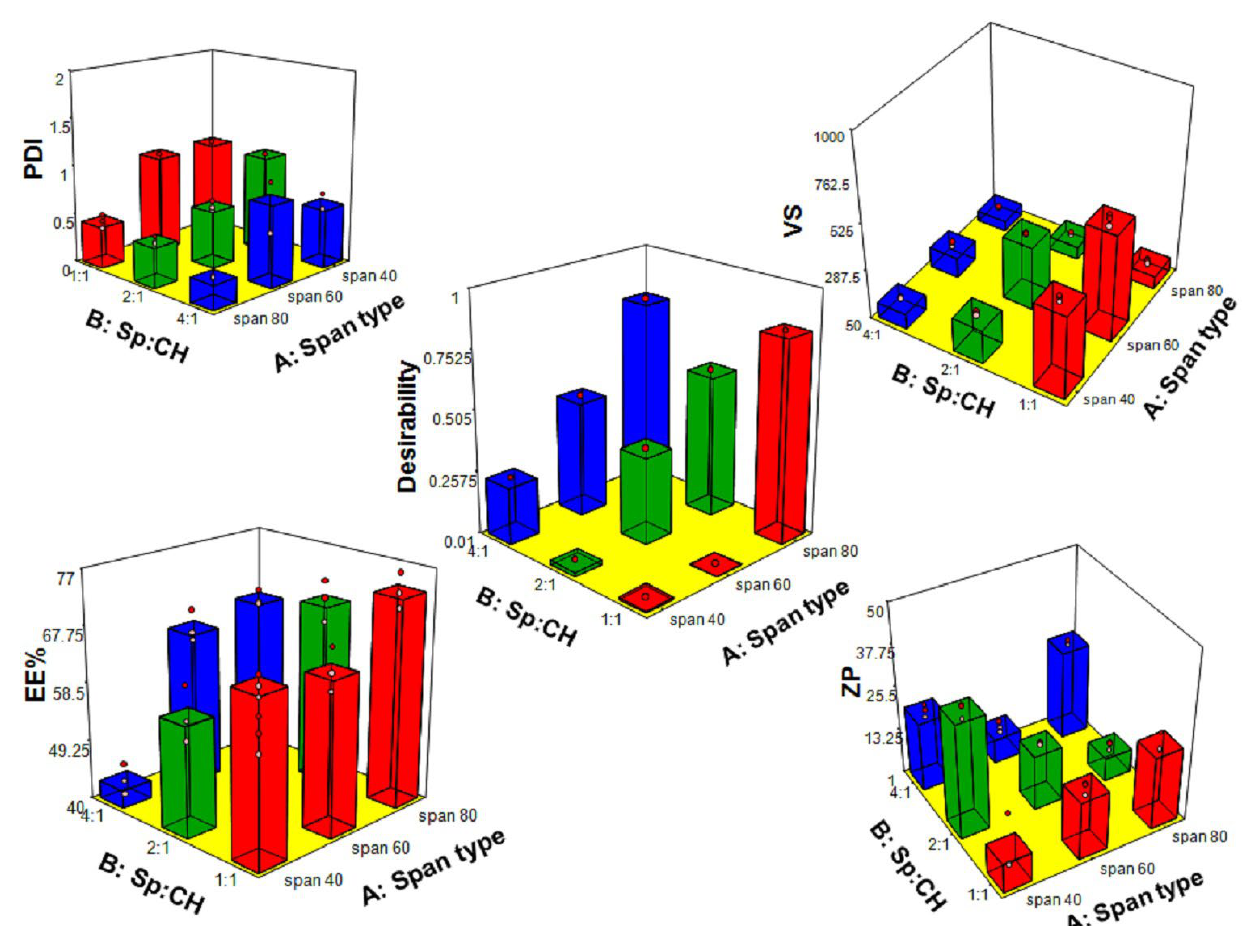
Figure 1. Three-dimensional Response plot for the effect of Span ® type (X1) and Span ® : cholesterol ratio (Sp:CH) (X2) on vesicle size (VS), polydispersity index (PDI), zeta potential (ZP), entrapment efficiency (EE%) and desirability of DRN loaded niosomes.